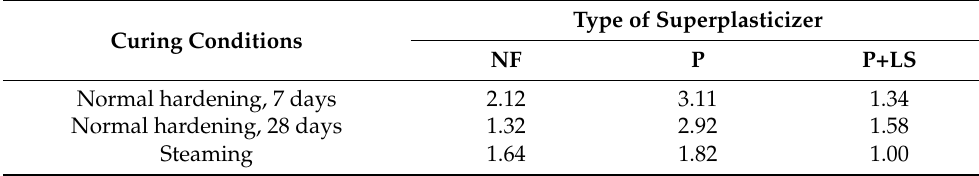
Table 6. Values of K c = ∆ f cm /WRE under different curing conditions and duration of LCSPC concrete. Curing